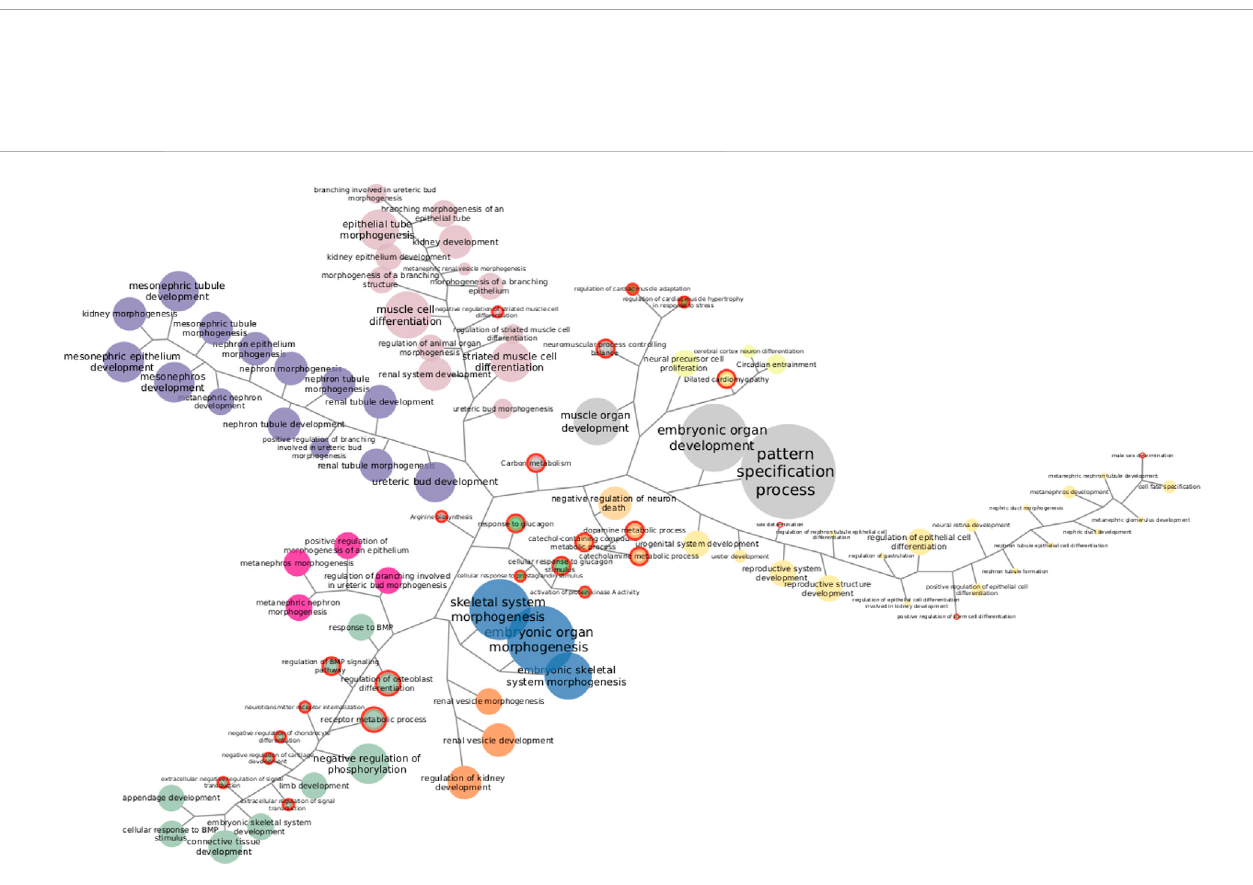
FIGURE 4 Functions enriched in Her2 SGCCA components. Both KEGG pathways and GO biological processes are represented together. Same-color clustered nodes are enriched in the same components. Nodes in gray do not belong to any cluster. The size of nodes and labels re fl ect the number of features behind the enrichment. Functions exclusively found in this subtype are highlighted with a red